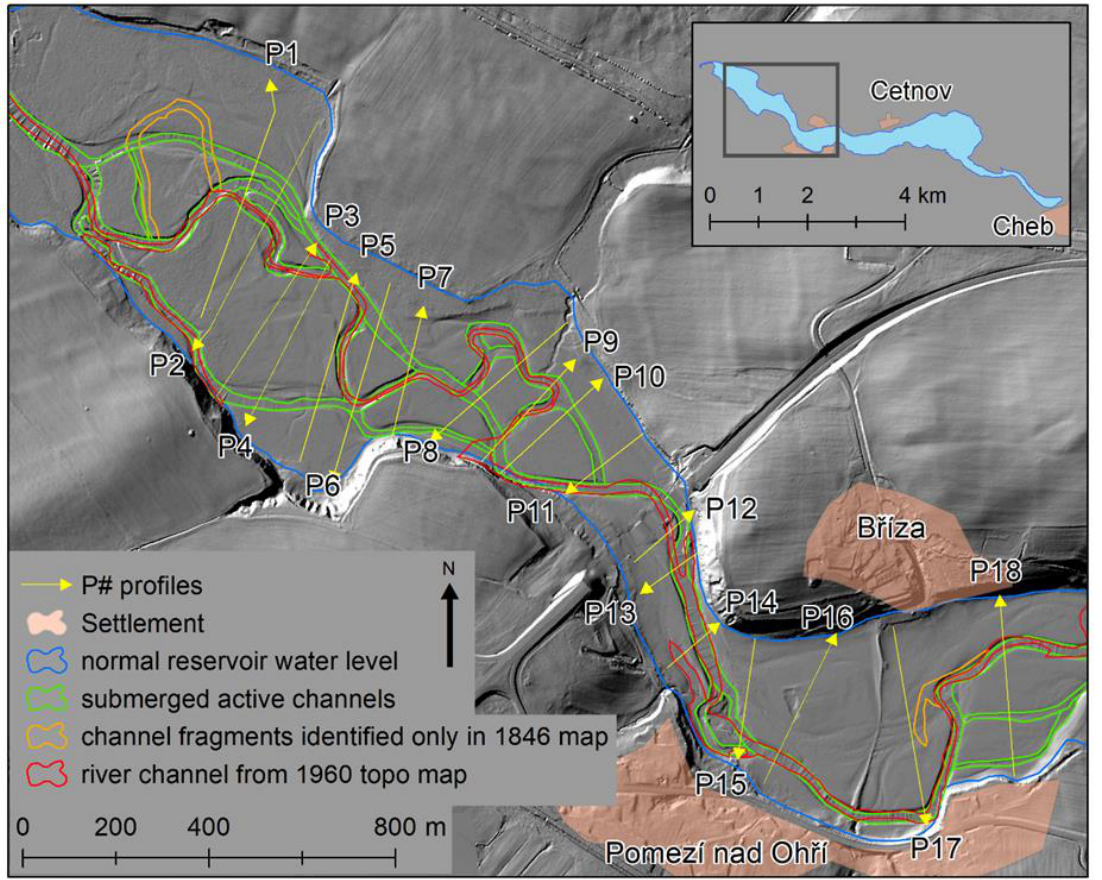
Figure 2. Detailed maps of the inflow to the Skalka Reservoir with positions of transect profiles (P#) and positions of banklines of historical and current channels of the Ohře River. The shaded light detection and ranging (LiDAR) data show the 2011 drawdown.